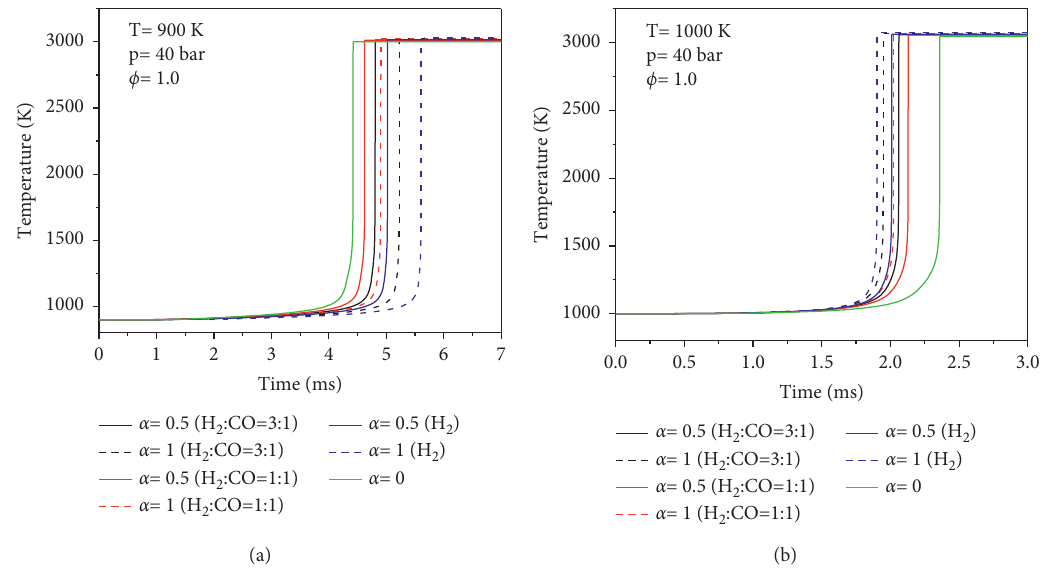
Figure 13: Effect of initial temperature and α on temperature evolution at β � 2.112 × 10 − 2 , bar, and ϕ � 1.